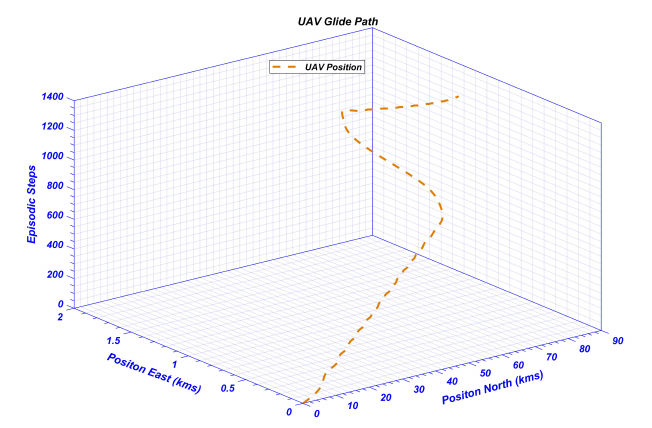
Figure 4. Glide path of UAV.